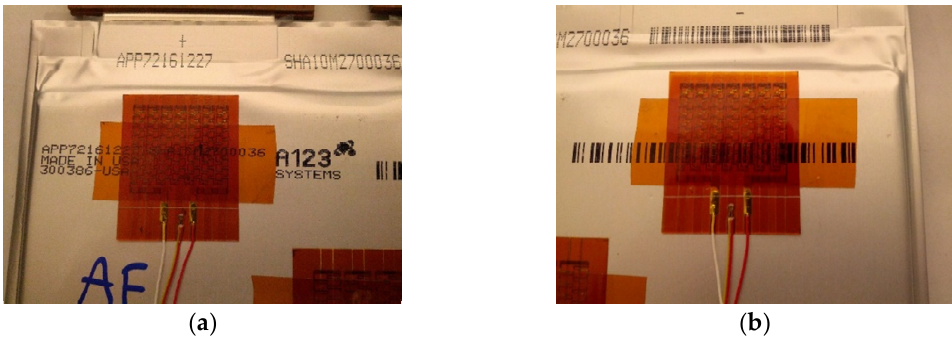
Figure 3. Heat flux sensors locations near ( a ) cathode and ( b ) anode. Table 1. Technical details of 20 Ah lithium-ion battery (LIB) cell.